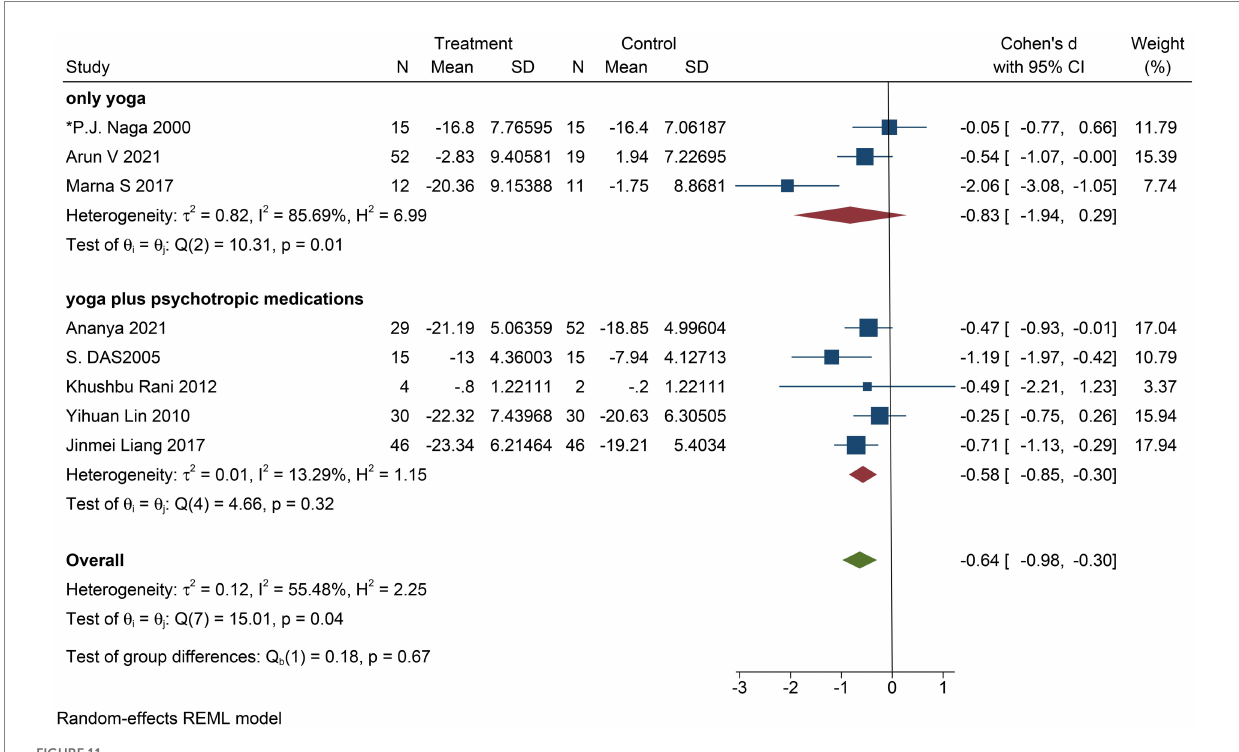
FIGURE 11 Forest plot of subgroup analysis regarding intervention